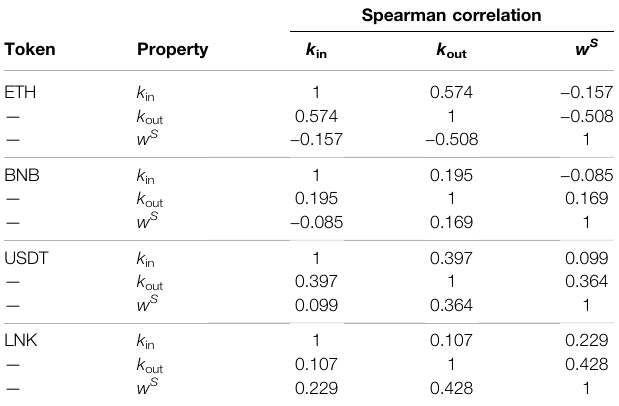
TABLE 5 | Spearman ρ correlation measures between cryptoassets for the measures of k in (in-degree), k out (out-degree), and w S (wealth). All p -values are lower that 10 – 10 , implying that we can reject the null hypothesis that the variables are not